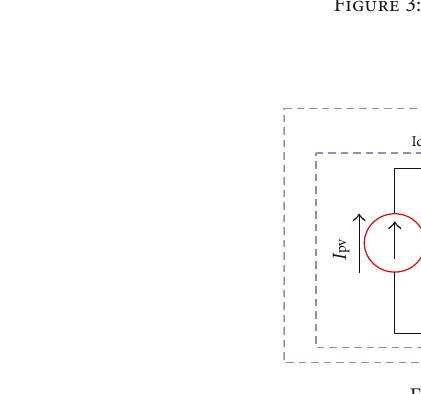
Figure 3: Complete HMC for a grid-connected PV system.